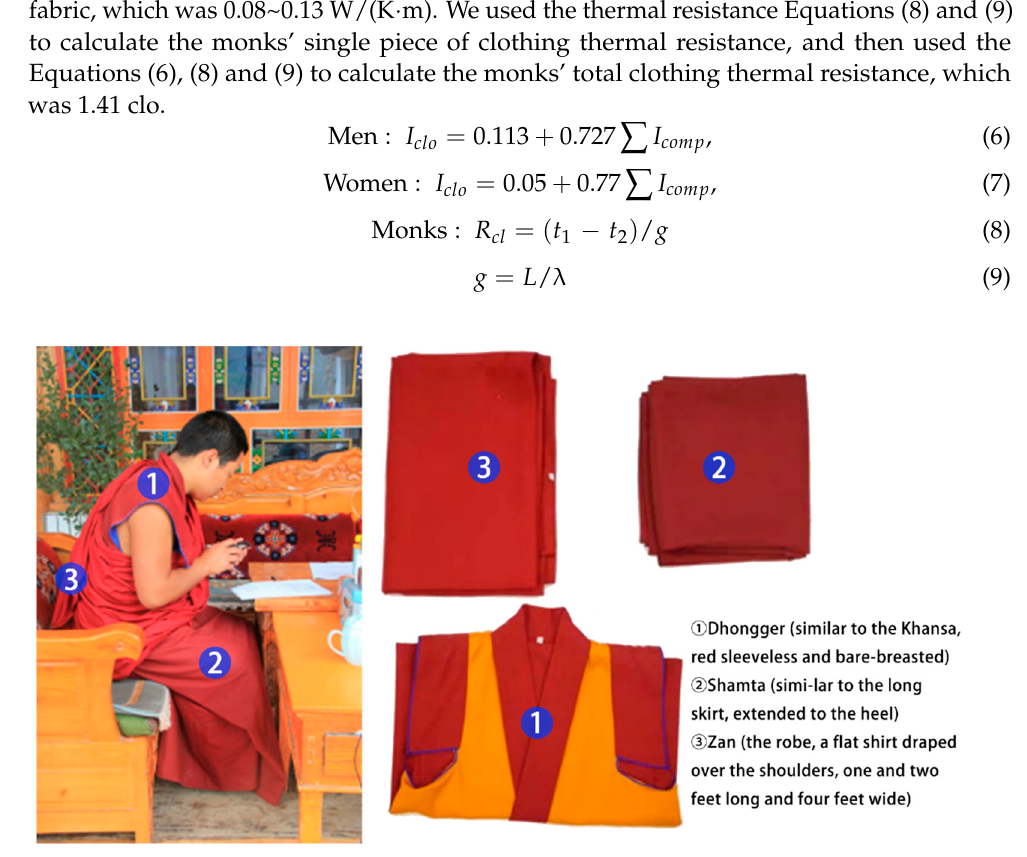
Figure 11. The dress (source: self-taken).